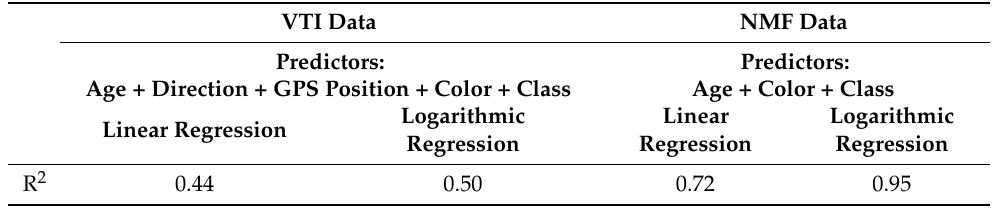
Table 7. Regression models for estimating retroreflectivity performance for VTI and NMF data.